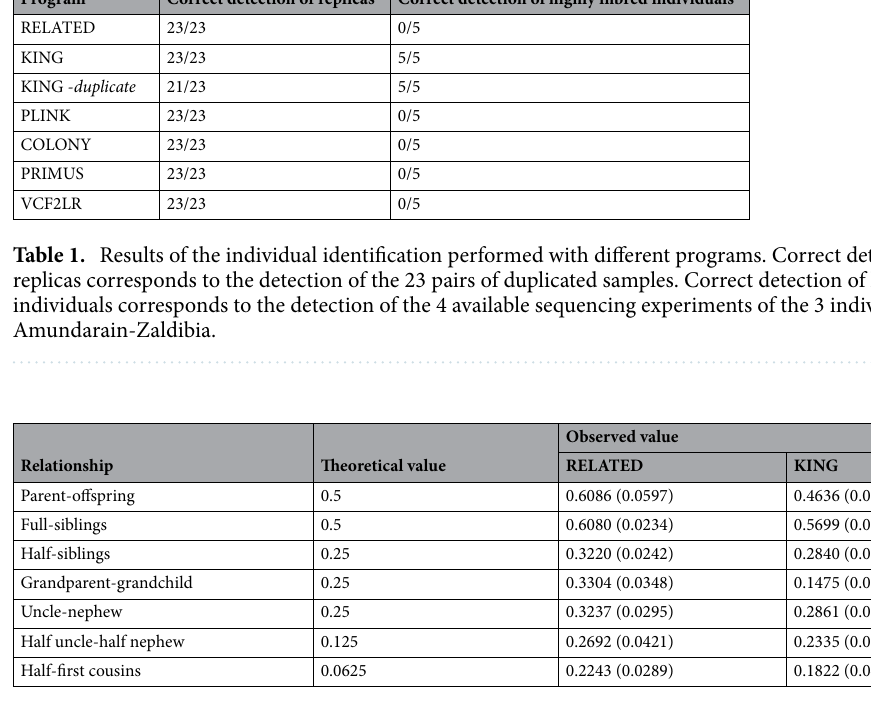
Table 2. Average relatedness values and standard deviations (in parentheses) estimated with different simulated pedigrees using the programs RELATED and KING in comparison with the expected values. The values corresponding to each pedigree can be found in Supplementary Tables S4 and S5.